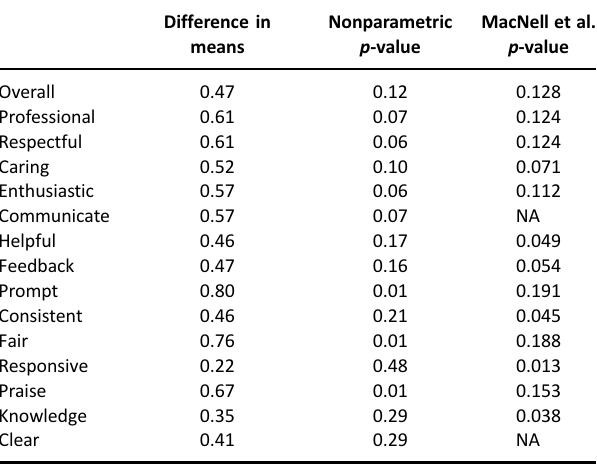
Table 8. Mean ratings and reported instructor gender (male minus female).